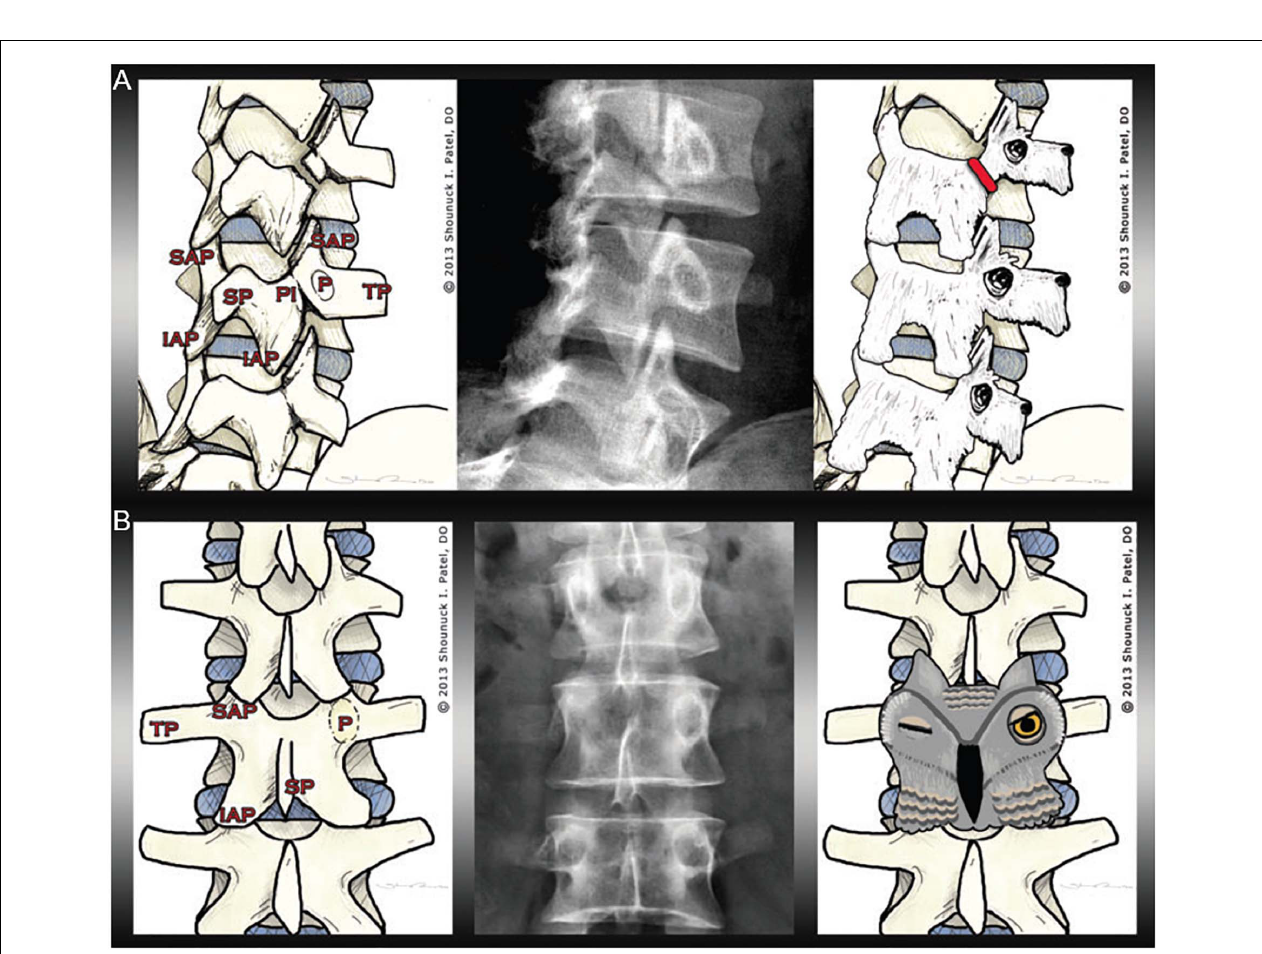
FIGURE 7 | Examples of pareidolia within musculoskeletal pathology. The left image in (A) illustrates the anatomy of the lumbar spine, including the transverse process (TP), the superior articular process (SAP), the inferior articular process (IAP), the spinous process (SP), the pedicle (P), and the pars interarticularis (PI). The radiograph in the middle panel shows a fracture of the pars interarticularis. As demonstrated in the right panel, the vertebrae can be visualized as Scottie dogs, with pars interarticularis fractures resembling collars around the dogs’ necks. (B) The left image shows the musculoskeletal anatomy, including—crucially—the pedicle (P). In the middle panel, one pedicle is missing. The pedicles—as visualized in the right panel—resemble owl eyes: the owl appears to be winking when one pedicle is missing (for instance, if destroyed by metastatic cancer) (from Foye et al., 2014).